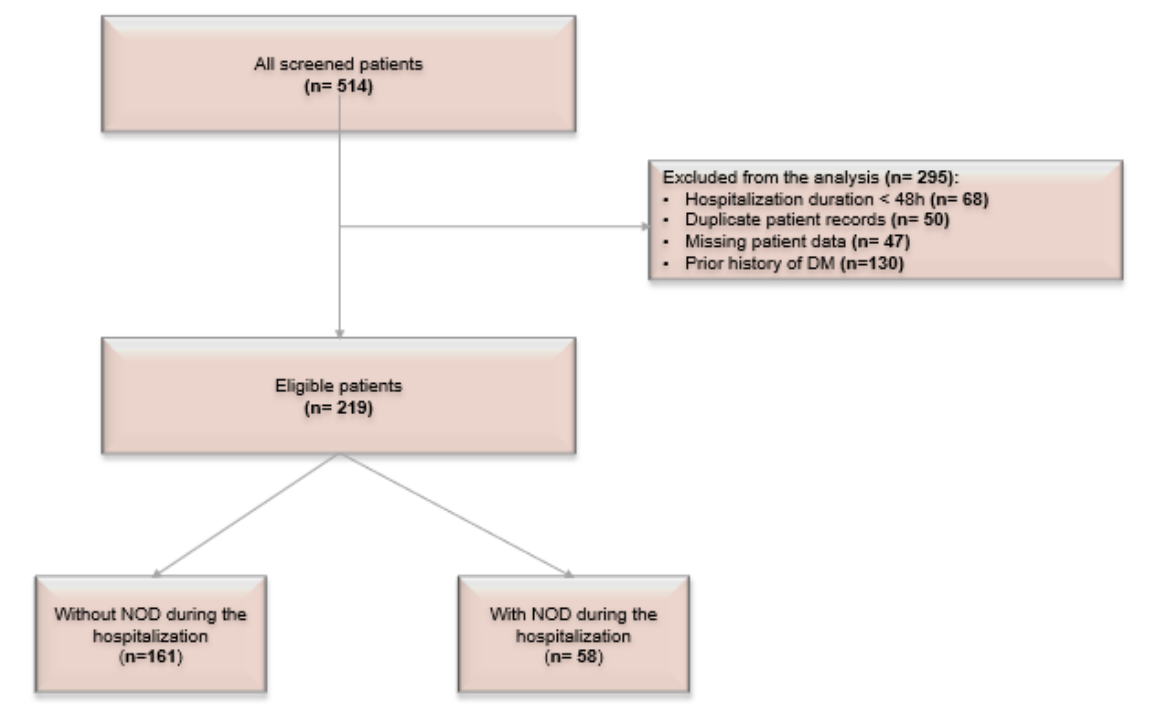
Figure 1. Flow chart of the population. NOD — new-onset diabetes